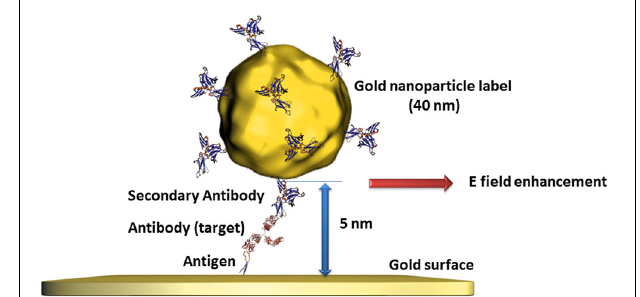
FIGURE 1 | Schematic presentation of the polarization of the electron density at resonant excitation wavelength. At particle sizes smaller than the excitation wavelength, the oscillating electrons (surface plasmons) cannot propagate along the gold surface leading to a polarization of the electron cloud at one side of the particle.